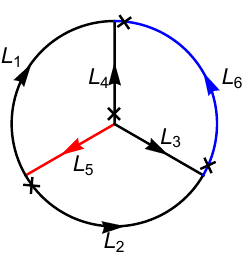
( L 5 ; L 6 ) represented as the correlation functional L 2 ; L 3